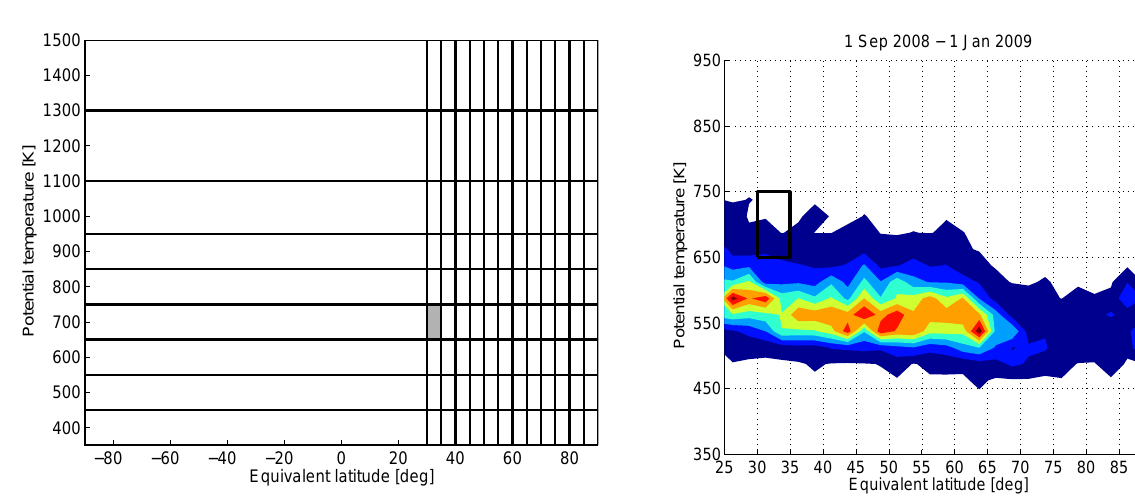
Fig. 5. Zonal mean tracer mixing ratio of a selected origin tracer (30–35 ◦ N equivalent latitude and 650–750K) at the start of a model run (1 September 2008, the black box is the area of mixing ratios of 100%) and in early winter (1 January 2009, filled